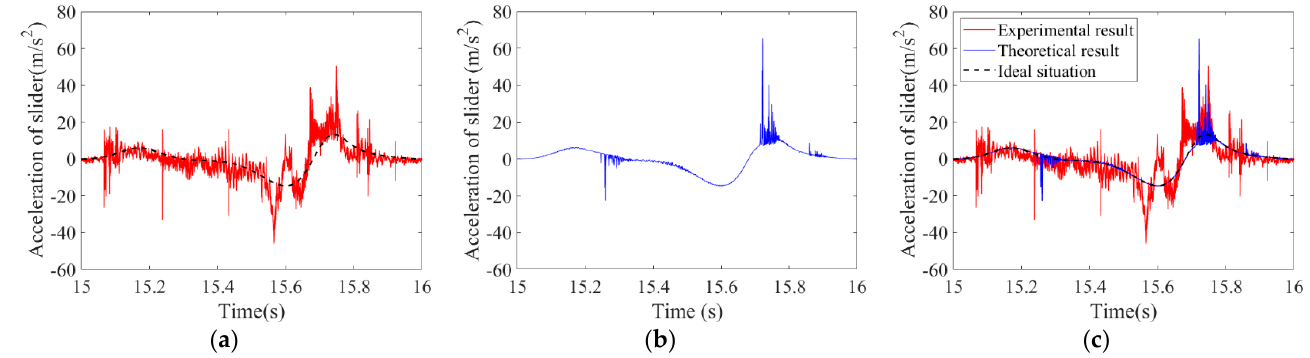
Figure 16. Comparison between experimental results and theoretical results. ( a ) Experimental result. ( b ) Theoretical result. ( c ) Comparison diagram. Table 5. The comparison between the theoretical and experimental results.